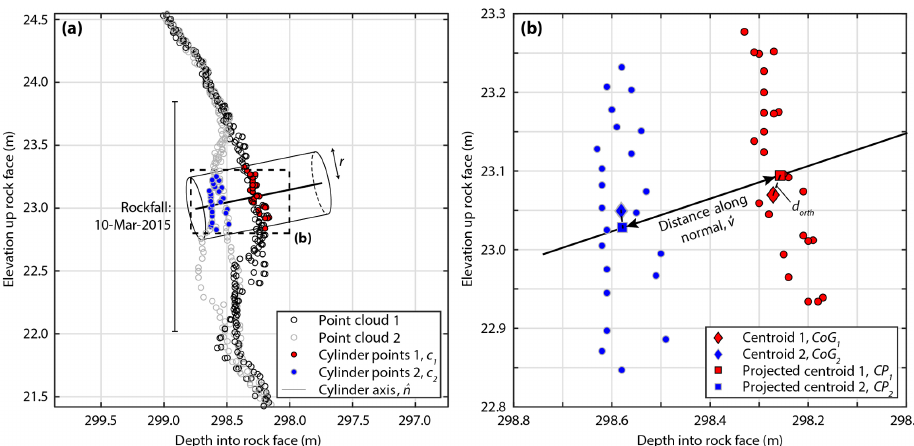
Figure 7. Approach to change detection used in this study based on empirical rockfall data. (a) A 2m wide transect taken midway up East Cliff. The black points are taken from Cloud 1 and the grey from Cloud 2, with a 1.75m high rockfall shown. Points within the cylinder radius, which intersects the two clouds, are shown as red and blue. The cylinder axis, which travels through the query point, is also shown. (b) Area of interest selected from (a) the centroids of each point cloud are determined and their orthogonal projection onto the normal vector (cylinder axis) is estimated (dashed lines). The distance measured in this study is between these projections, along the